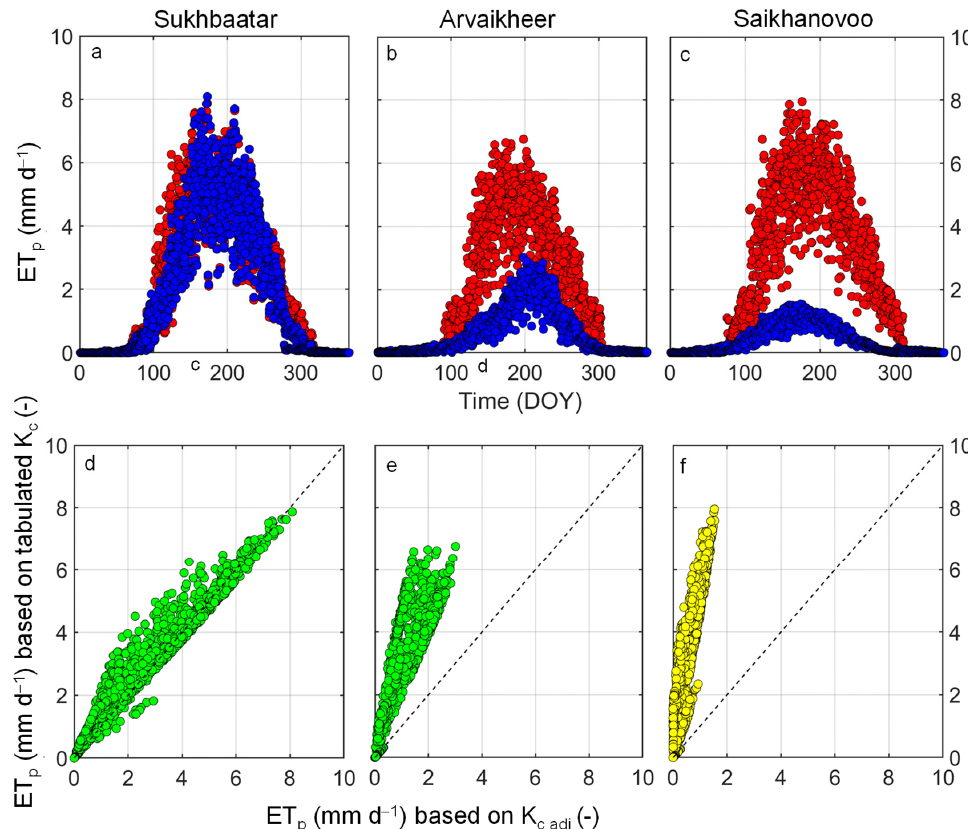
Figure 8. Comparison between daily ET p values based on K c adj (blue circles) and ET p values based on tabulated K c (red circles) over ( a ) Sukhbaatar, ( b ) Arvaikheer, and ( c ) Saikhanovoo. The data scatter (green and yellow circles distinguish steppe and Gobi Desert) around the identity line (1:1 line represented by the diagonal dashed line) is illustrated in ( d ) Sukhbaatar, ( e ) Arvaikheer, and ( f ) Saikhanovoo.